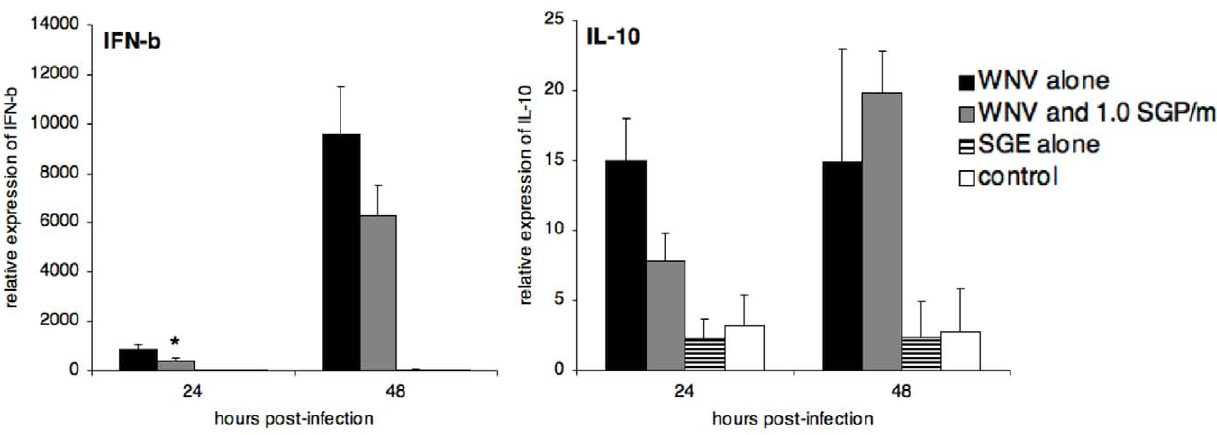
Figure 3. Cytokine mRNA expression in bone marrow-derived DCs following infection with WNV. IFN- b and IL-10 levels were assessed by real-time RT-PCR at 24 and 48 h post-infection (MOI=5). Their mRNA expression levels were normalized to those of the GAPDH gene. The means 6 standard deviation are shown, and an asterisk signifies a statistically significant difference (p , 0.05) as compared to the group infected with WNV alone as determined by Mann-Whitney test. IFN- c , IL-2, IL-4, IL-12, and IL-1 b mRNA expression, as well as WNV titers (assessed by titration on cell culture) were found not to vary among groups (data not shown). Control groups were mock infected with PBS alone. This experiment was repeated three times.